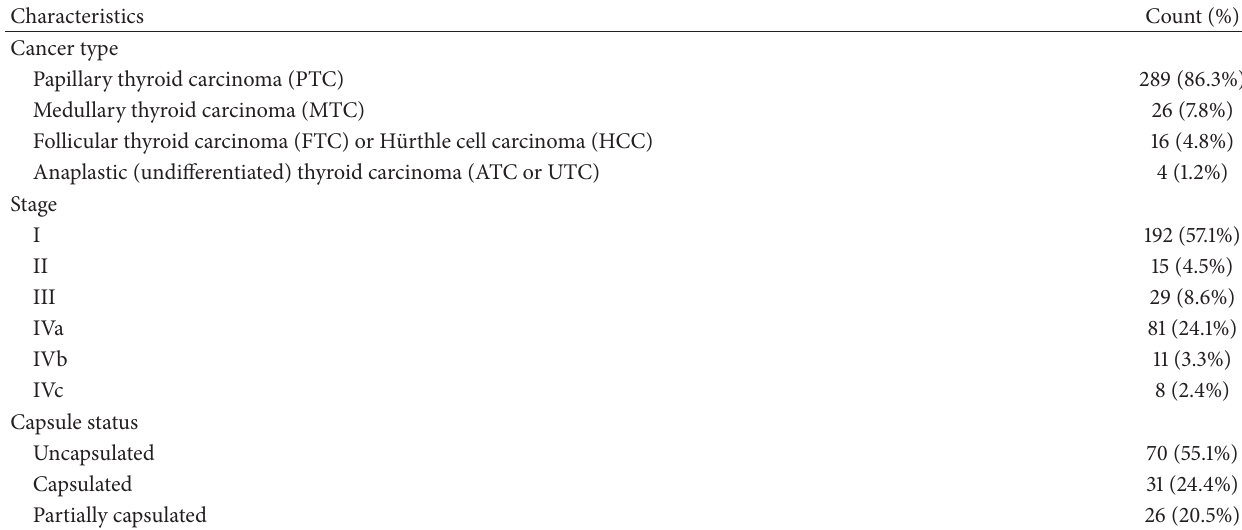
Table 3: Demographic and clinicopathological